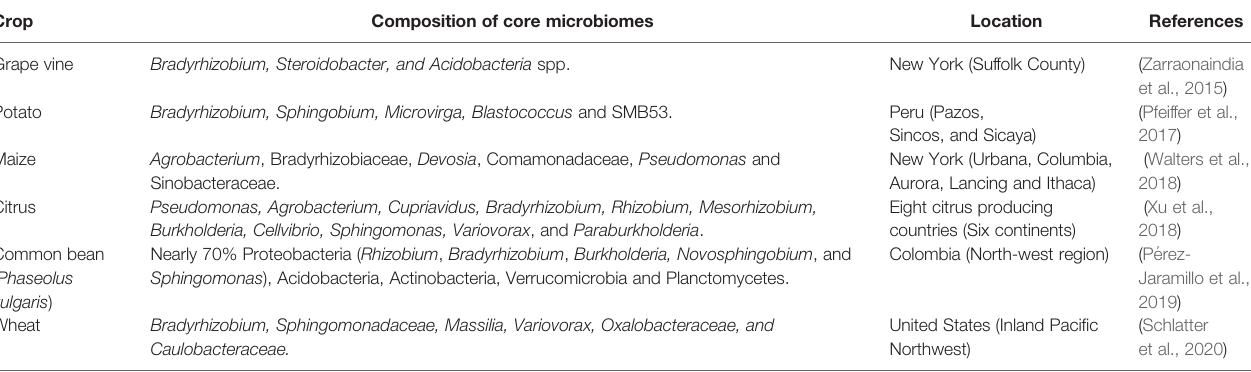
TABLE 1 | Studies related with core microbiome identi fi cation in agricultural